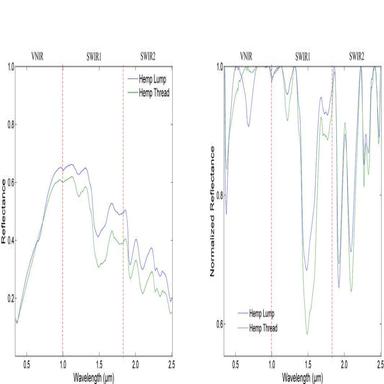
Spectral comparison between textile samples with different physical properties. (the 1st column: reflectance spectra; the 2nd column: CR spectra).